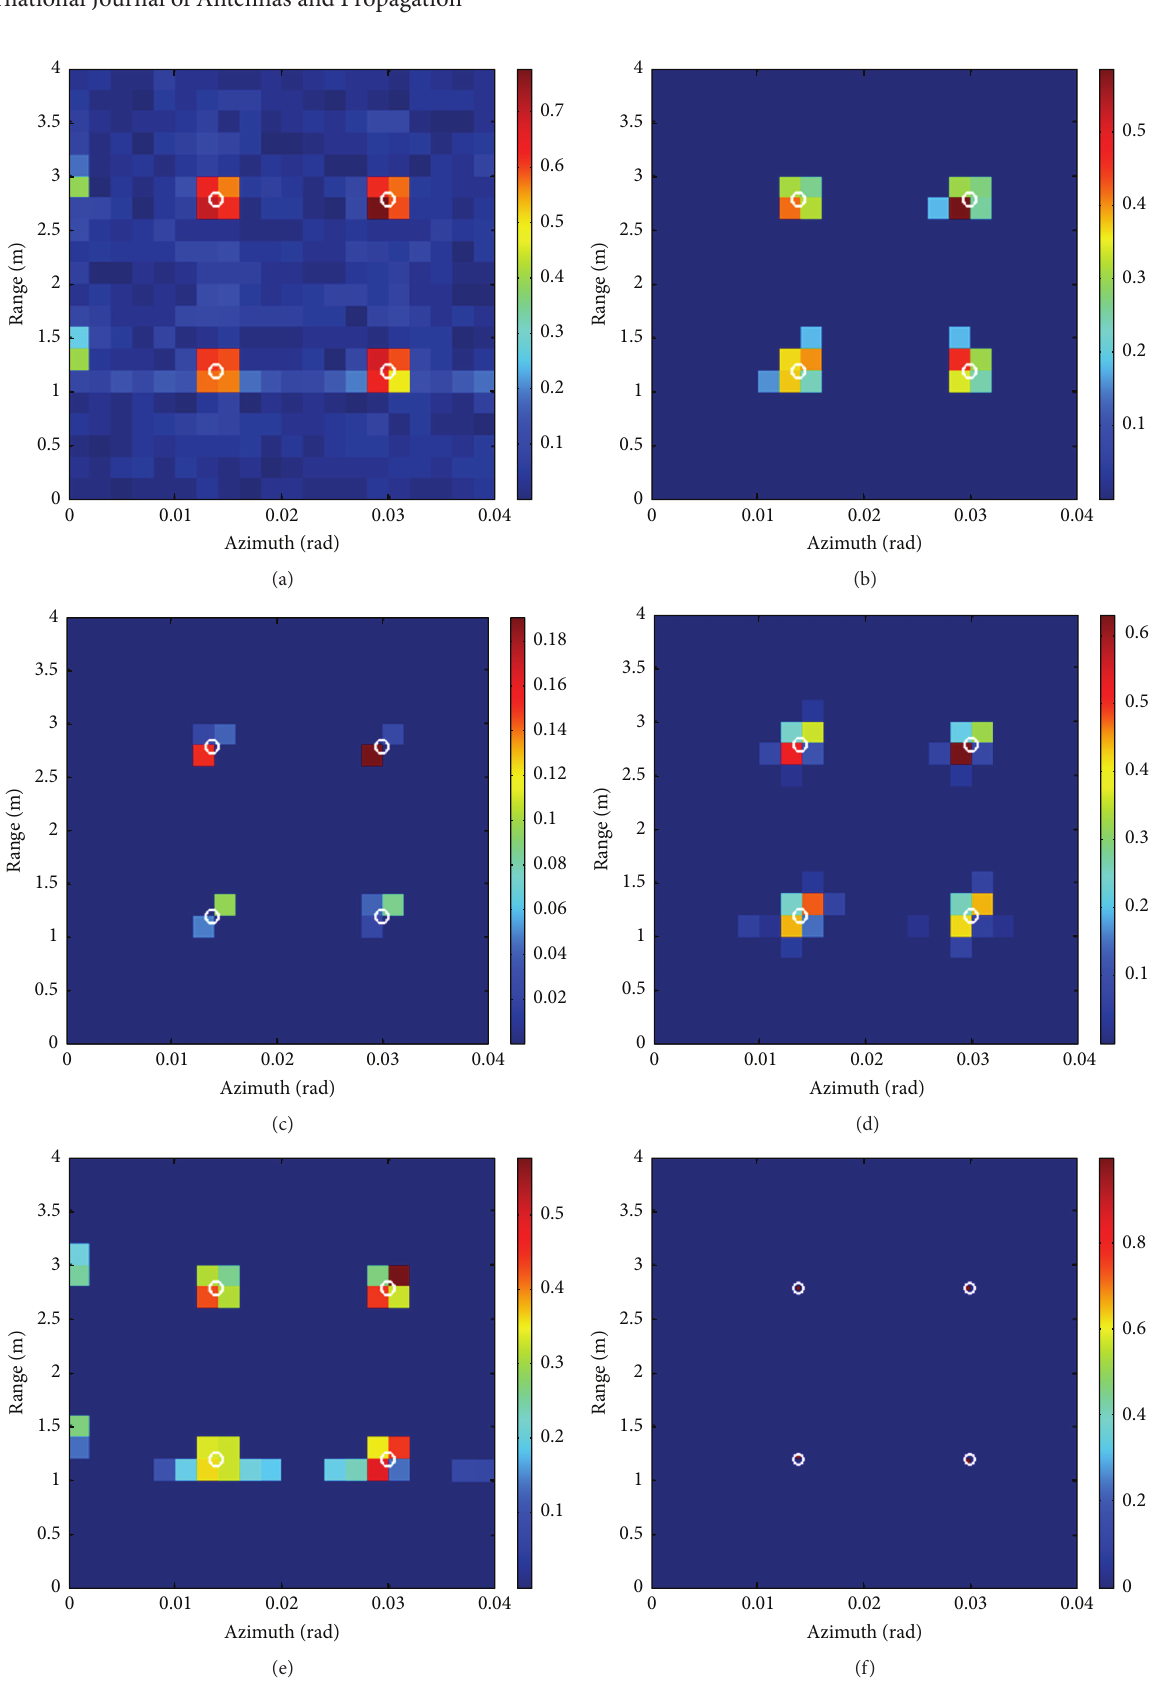
Figure 8: RCI results when 𝜁 = 0.61 . (a) MF, (b) OMP, (c) BPDN, (d) S-TLS, (e) CP, and (f) 2D